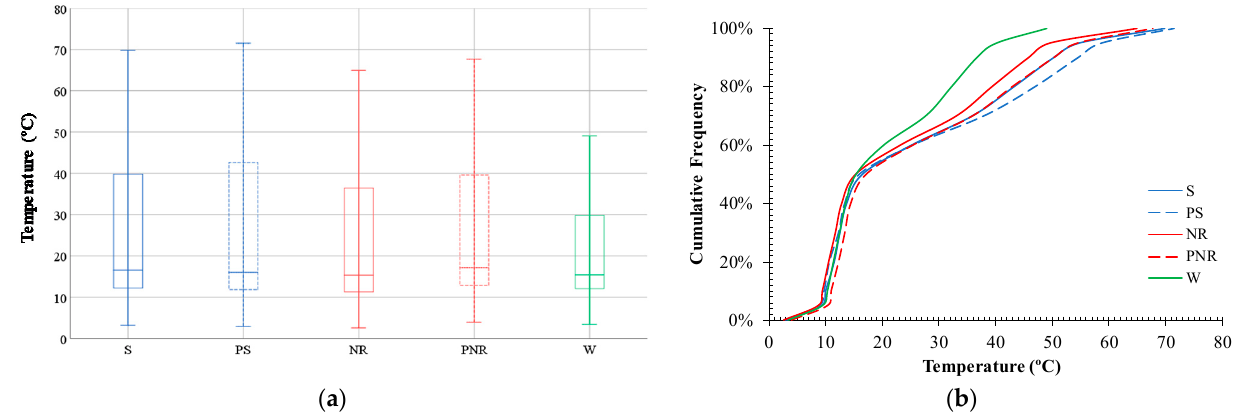
Figure 9. Surface temperature in: ( a ) Day of lower temperatures (M12); ( b ) Day of high temperatures (M13). A statistical analysis of a representative week of each period (mild and hot) is shown in Figures 10 and 11, respectively.